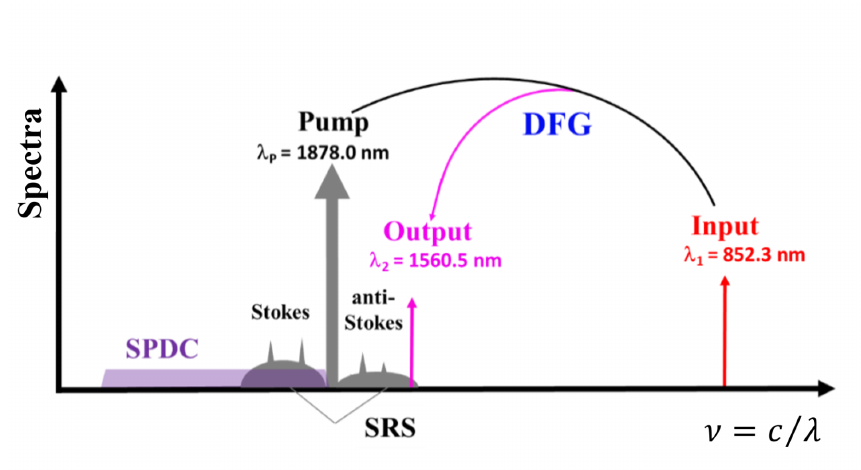
Figure 3. Nonlinear process of conversion of 852-nm photons to 1560-nm photons based on 1878-nm pump laser. SPDC, spontaneous parameter down conversion (purple area); SRS, spontaneous Raman scattering (Stokes and anti-Stokes photons, gray area).